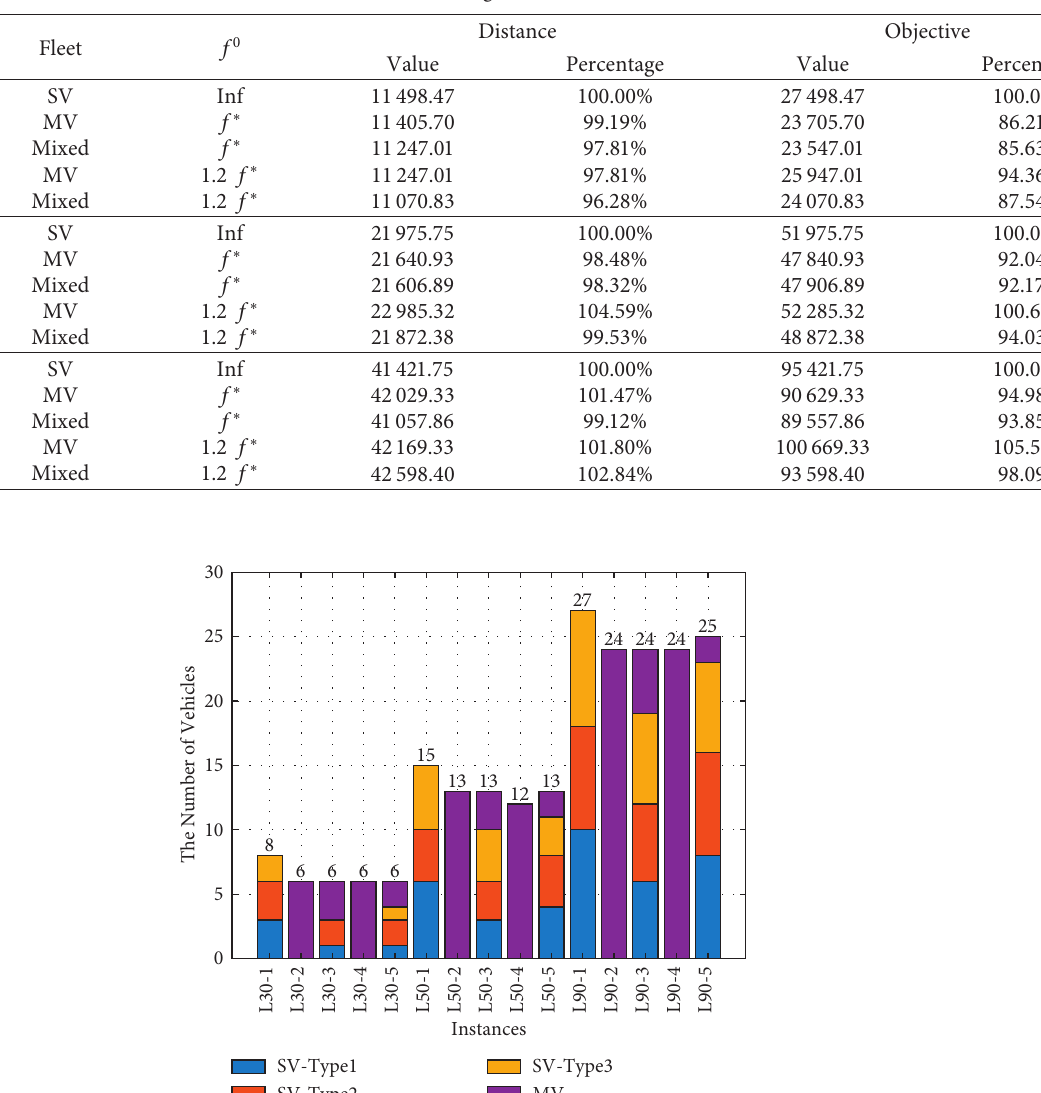
Table 5: Results of large-scale